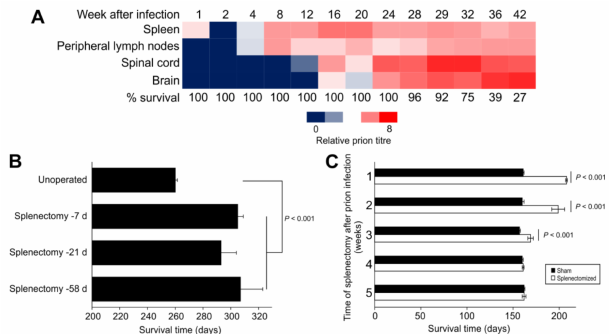
Figure 1. The spleen is an important early site of prion replication and neuroinvasion after peripheral infection. ( A ) In 1967, Eklund et al. [17] showed that high levels of RML scrapie prions accumulated in the spleens of Swiss mice within days after subcutaneous injection, and this occurred before the prions were detected in the spinal cord and brain. Heatmap shows negative log10 of dilution of tissue suspension that contained 1 LD 50 / 30 µ L when injected intracerebrally into recipient mice. ( B ) In 1970, Fraser and Dickinson [21] showed that splenectomy before IP injection of C57BL / Dk mice with ME7 scrapie prions significantly extended the survival times. Bars, mean ± SEM; n = 3–22 mice / group. ( C ) In 1989, Kimberlin and Walker [31] concluded that splenectomy did not extend survival times once infection was established in the spinal cord. In their experiment Compton White mice were IP injected with 139A scrapie prions and the splenectomy performed at the times indicated after prion injection. Bars, mean ± SEM; n = 4–9 mice /